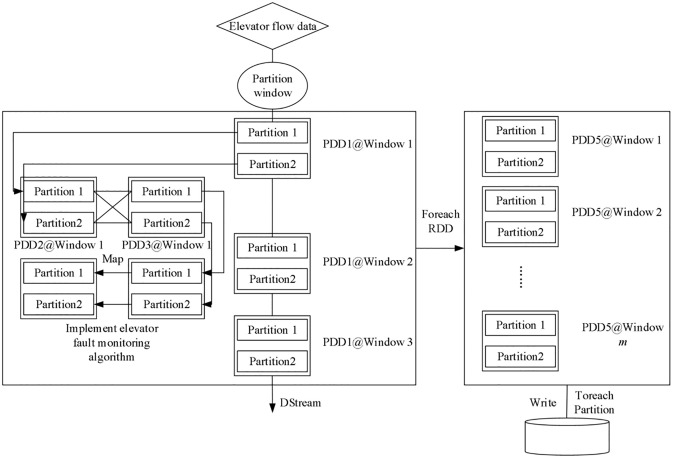
Flow chart of elevator fault monitoring algorithm under flow data.